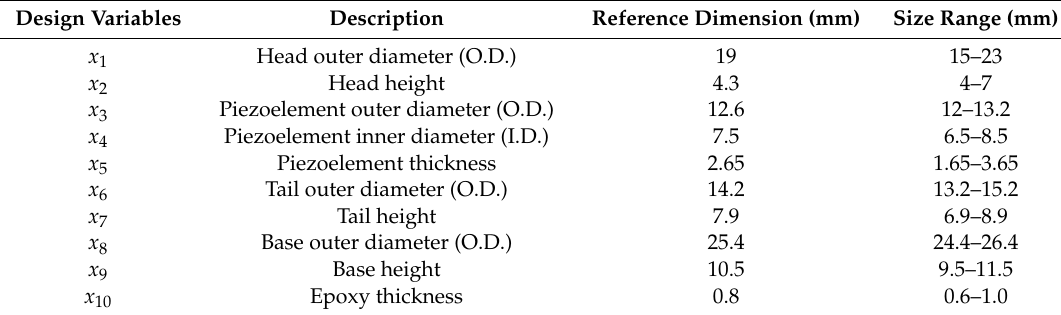
Table 3. Ten design variables and their size ranges used for numerical